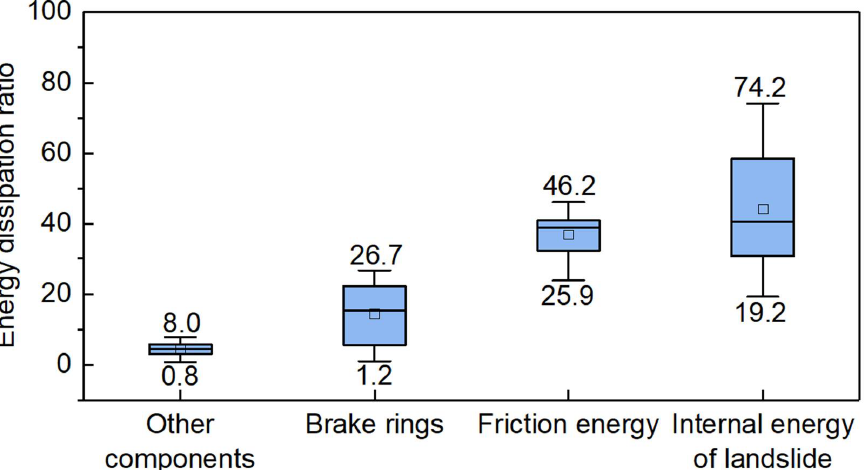
Figure 14. Energy dissipation distribution.